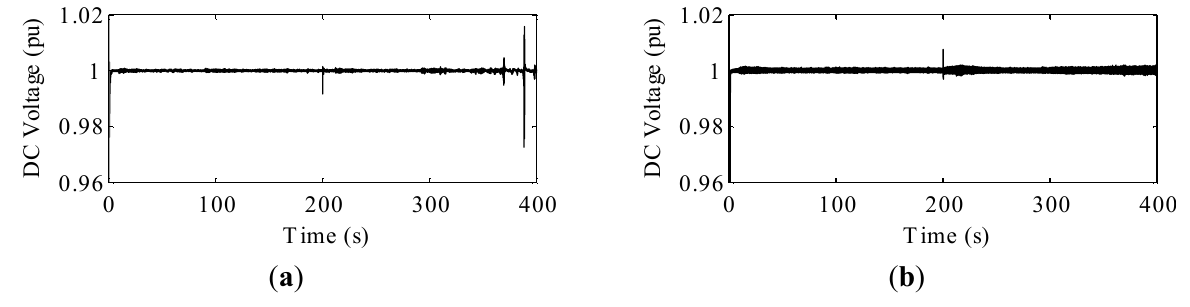
Figure 13. DC-link voltages of the back-to-back converter: ( a ) the conventional FES system; ( b ) the proposed FES system.